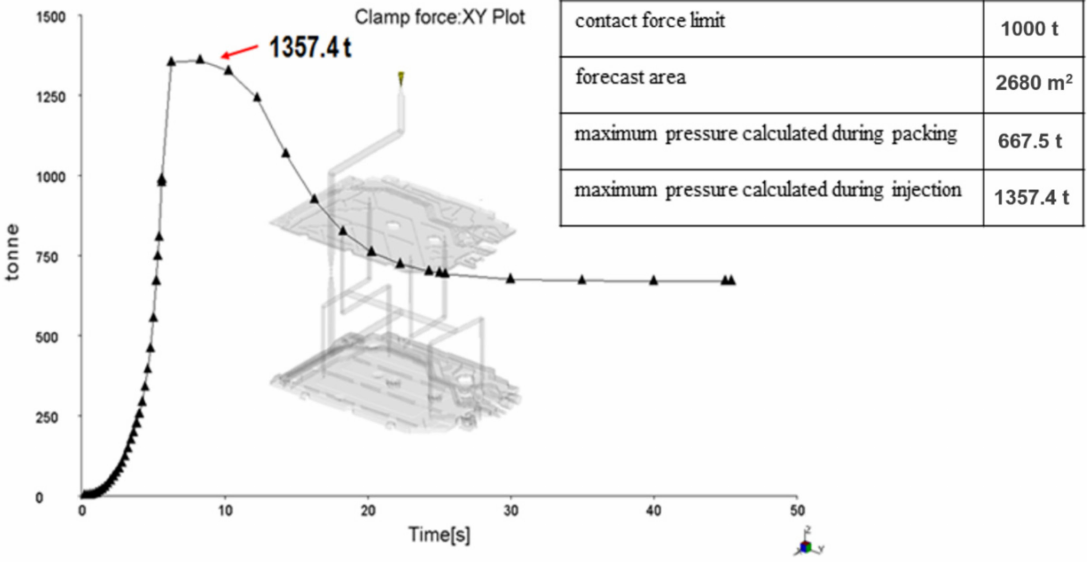
Figure 11. Clamping force